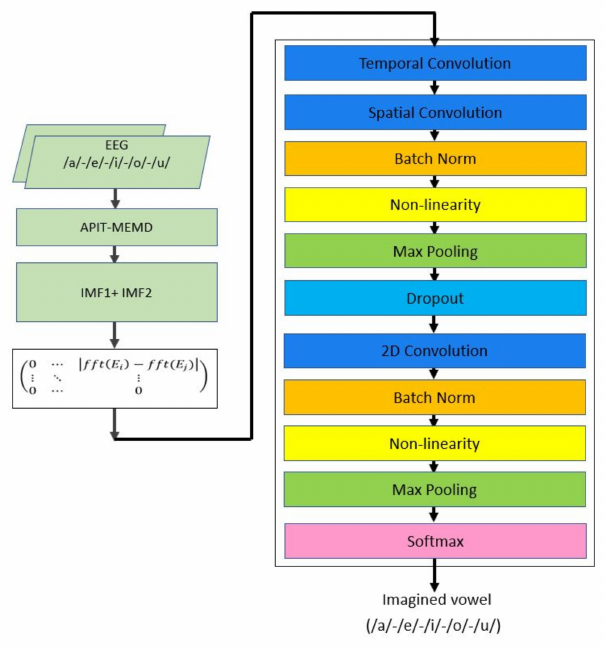
Figure A2. Reference architectures with